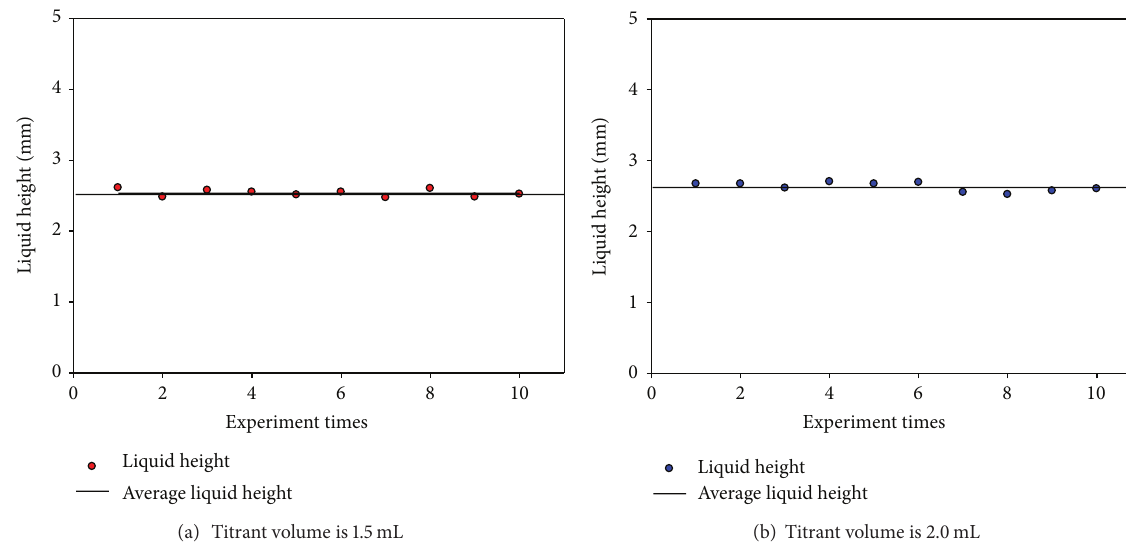
Figure 10: Liquid height via different titrant volumes.